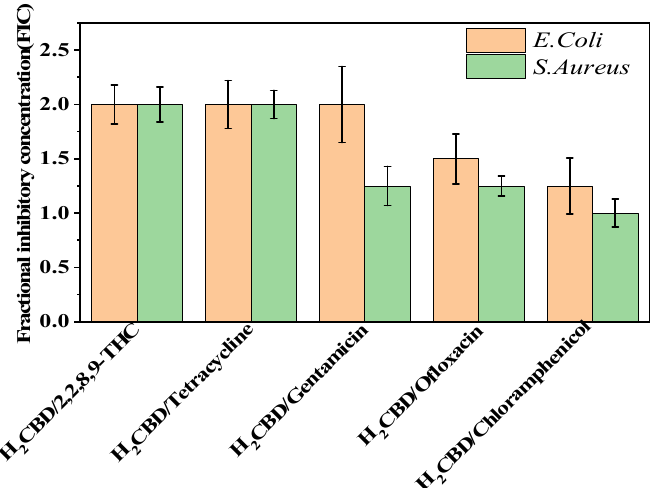
Figure 2. Synergy test on S. aureus and E. coli. Therefore, H 2 CBD and CBD may serve as alternatives to tetracycline hydrochloride, gentamicin, chloramphenicol, and ofloxacin against S. aureus , making them synthetic or botanic antibiotics, respectively.